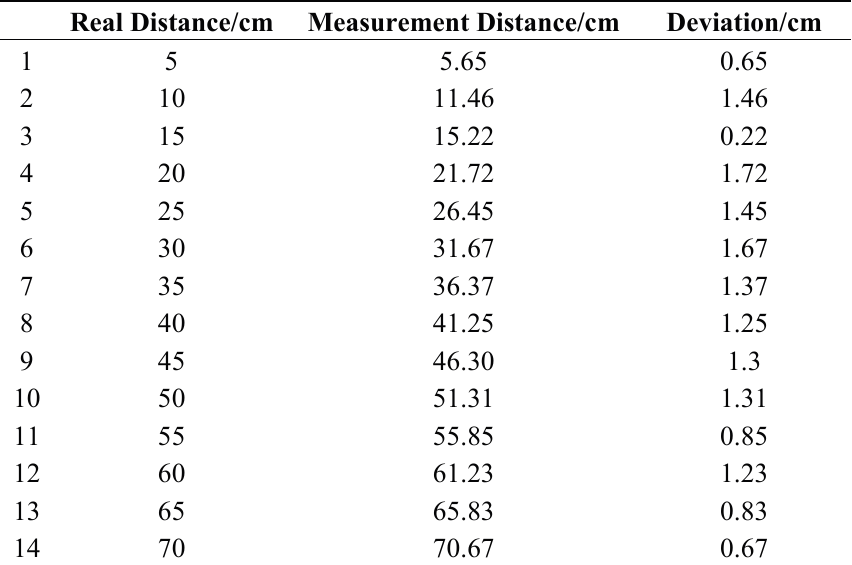
Figure 6. ( a ) Schematic diagram of the distance testing experiment; ( b ) The transmitting and receiving signal when the distance between the two CMUTs; The frequency of the transmitting signal is 250 kHz; ( c ) The measurement and real distances between the two transducers. Table 4. The real and measurement distances between the two CMUTs. Real